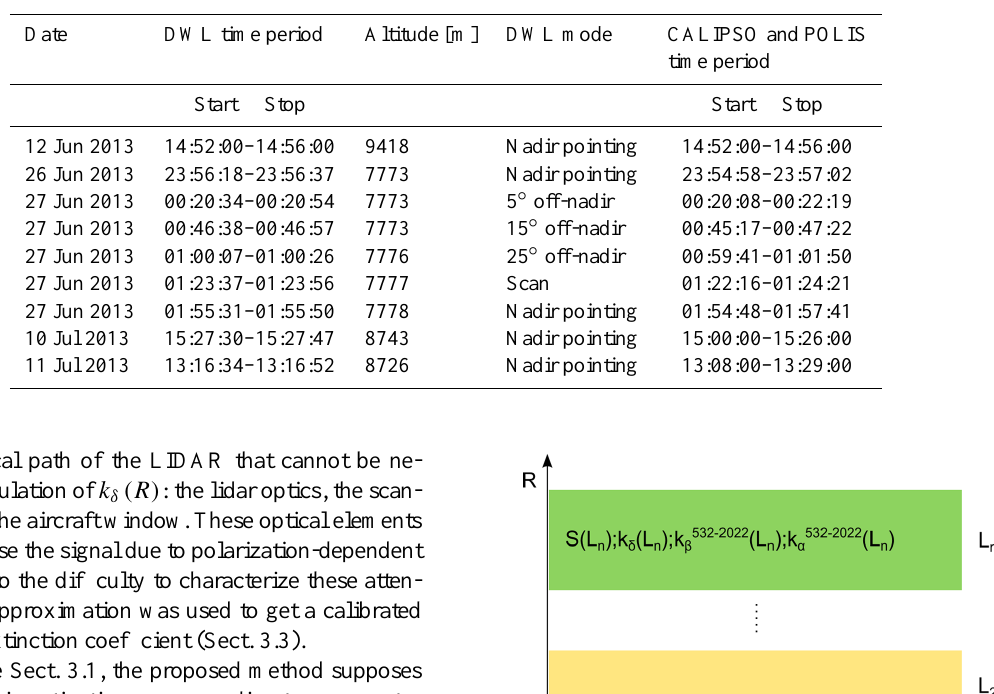
Table 2. List of flights below CALIPSO (12 June 2013) and over POLIS lidar (other dates). The overflights were defined as the time periods during which the DLR Falcon was flying in the region defined by a square cantered at the POLIS position with sides of 3km. Dates and time are in UTC.